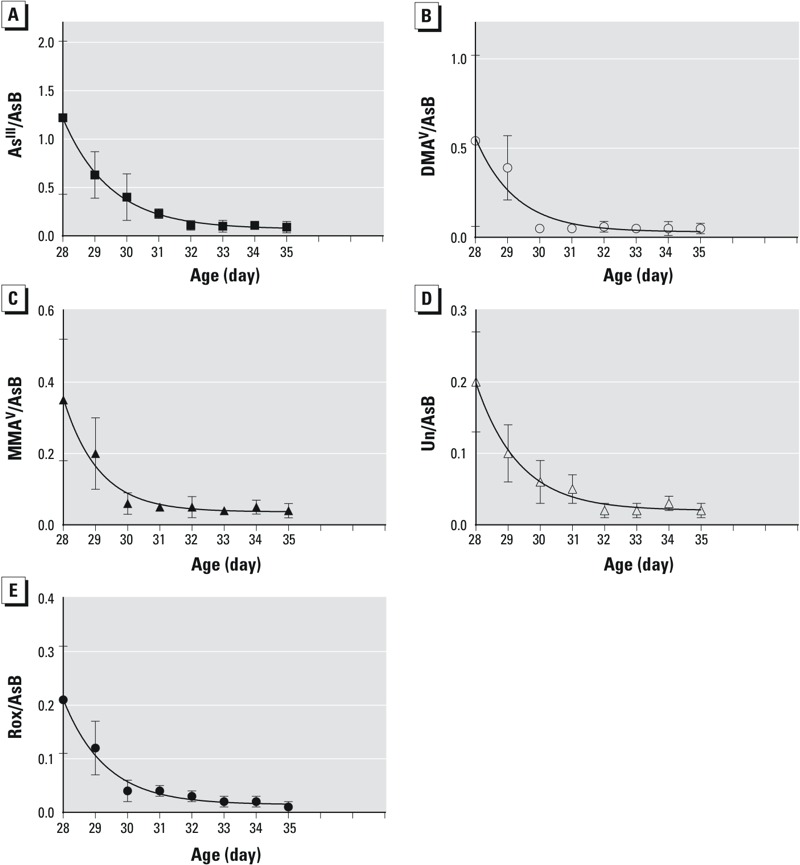
Concentrations of (A) AsIII, (B) DMAV, (C) MMAV, (D) Unknown arsenic species, and (E) Rox normalized against AsB, in the breast samples of Rox-fed chicken. Eight Rox-fed samples were collected each day from day 28 to day 35. Day 28 was the last day when these chickens were fed Roxarsone. From day 29 to day 35, all chickens were fed the control food that did not contain Roxarsone. Data points were presented as mean and one standard deviation from duplicate analyses of each of the 5–8 breast samples. The curve represents the best fit of the data using one-phase exponential decay function.